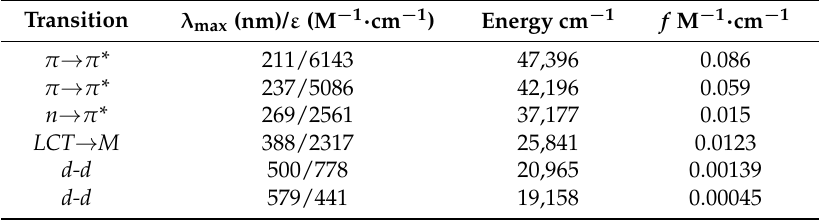
Table 3. UV-Vis data of 1 , with the oscillator strength value, f